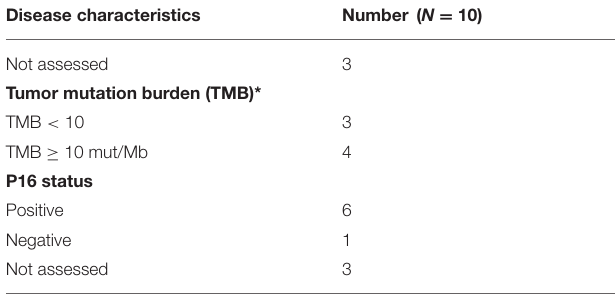
TABLE 1 | Baseline demographics and disease characteristics. Disease